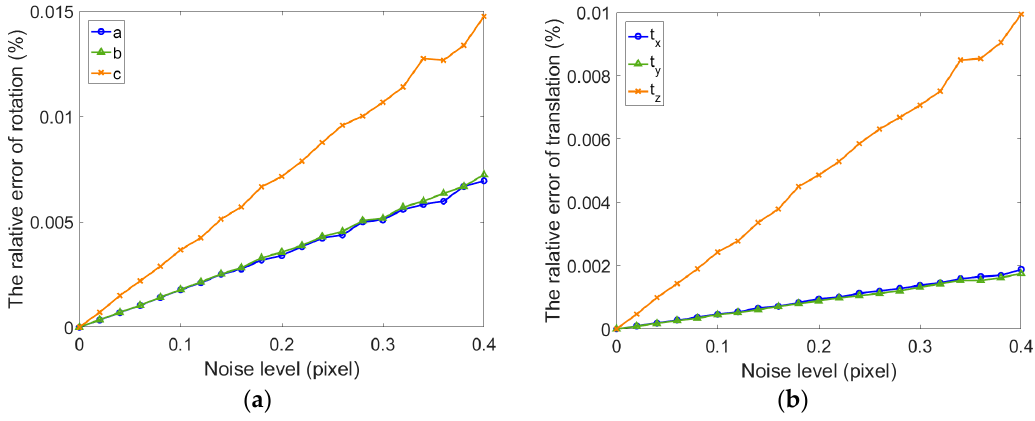
Figure 6. The relative error of extrinsic parameters for one camera without refraction estimation. ( a ) Relative error for the rotation vector; ( b ) Relative error for the translation vector.